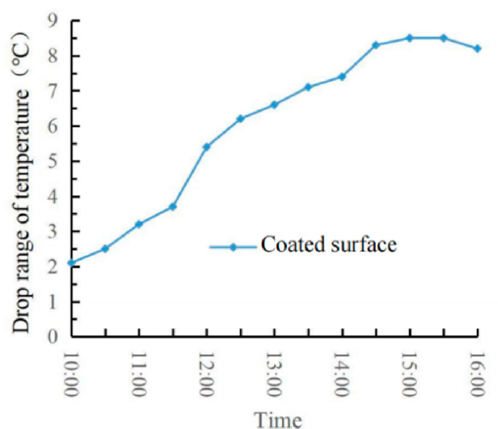
Figure 17. Real-time temperature chart.